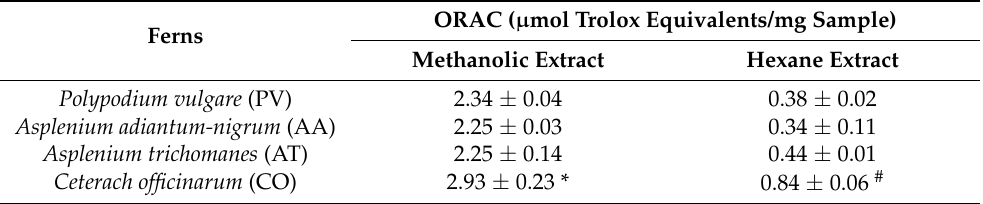
Table 2. ORAC values of methanolic and hexane extracts of fern species. Ferns